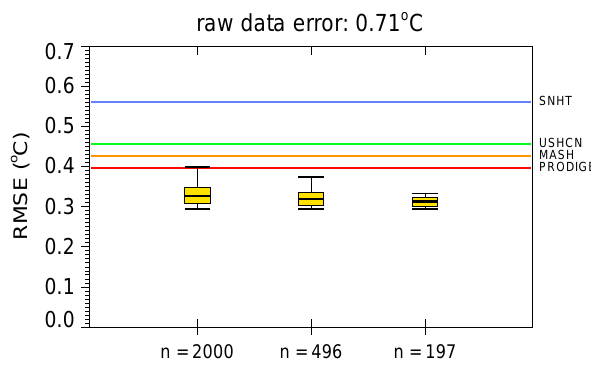
Figure 4. The same as Fig. 2, but for the RMSE of monthly values.